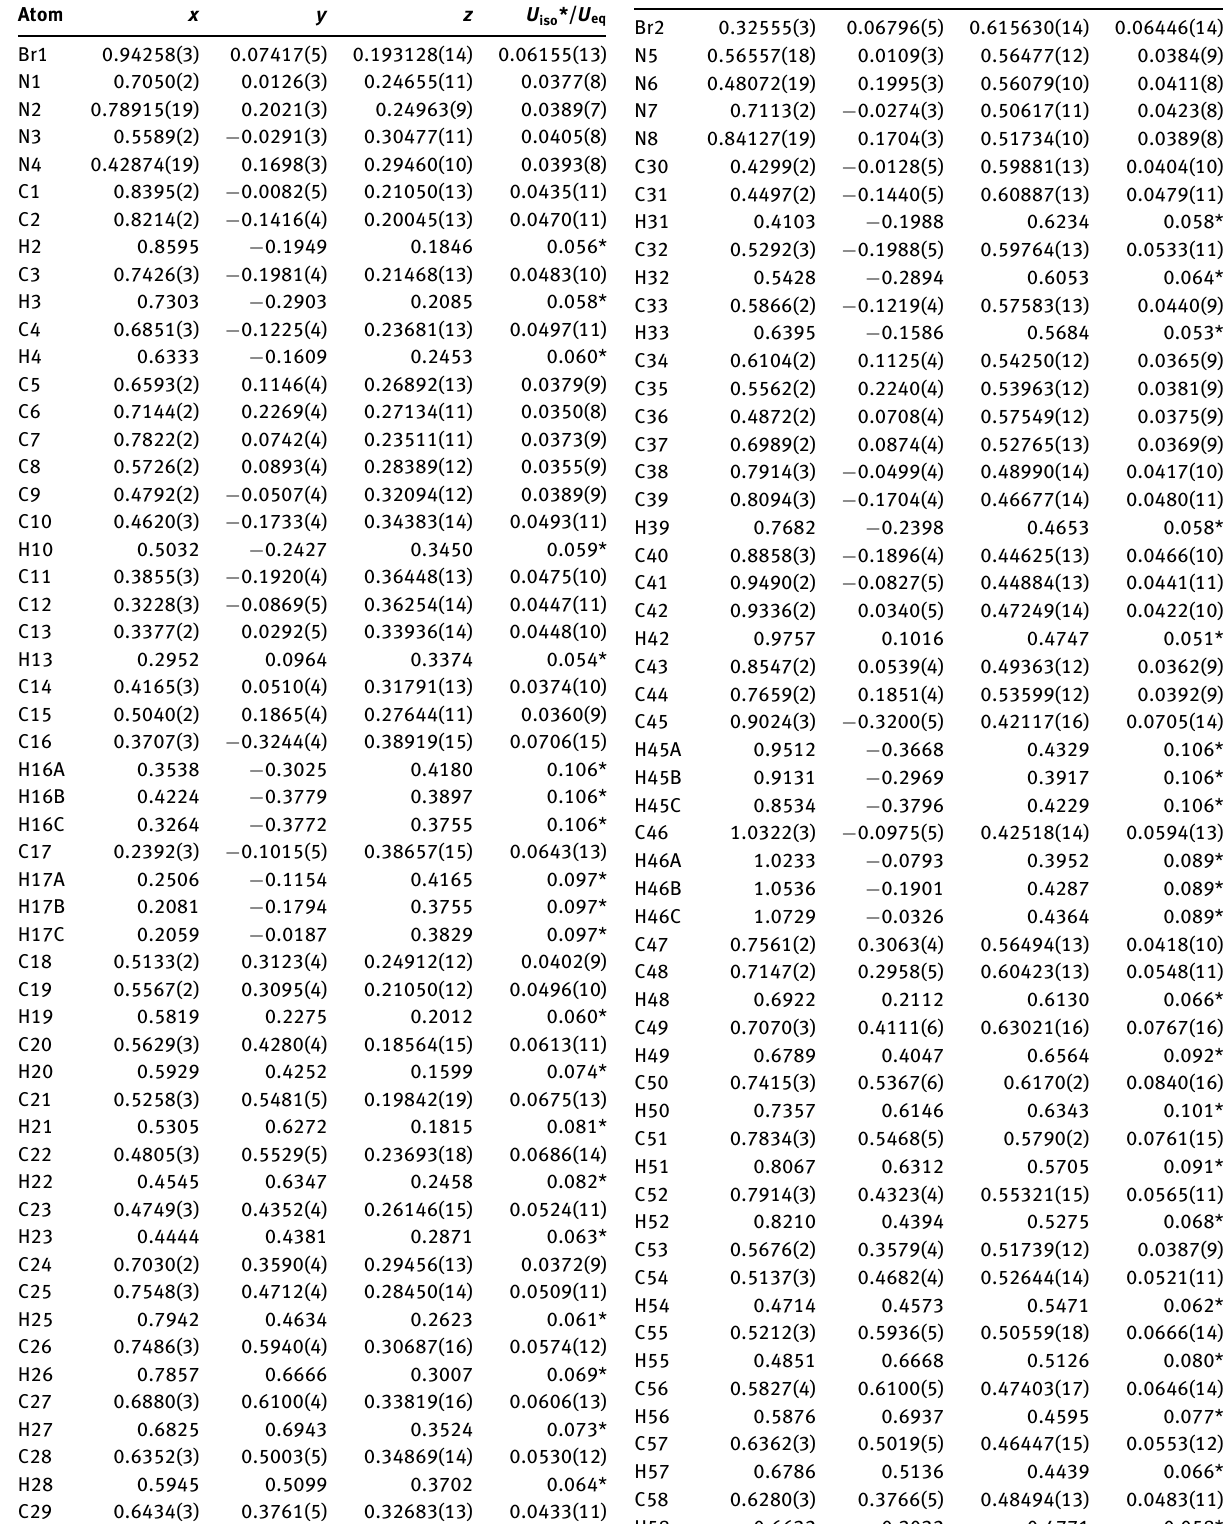
Table 2: Fractional atomic coordinates and isotropic or equivalent isotropic displacement parameters (Å 2